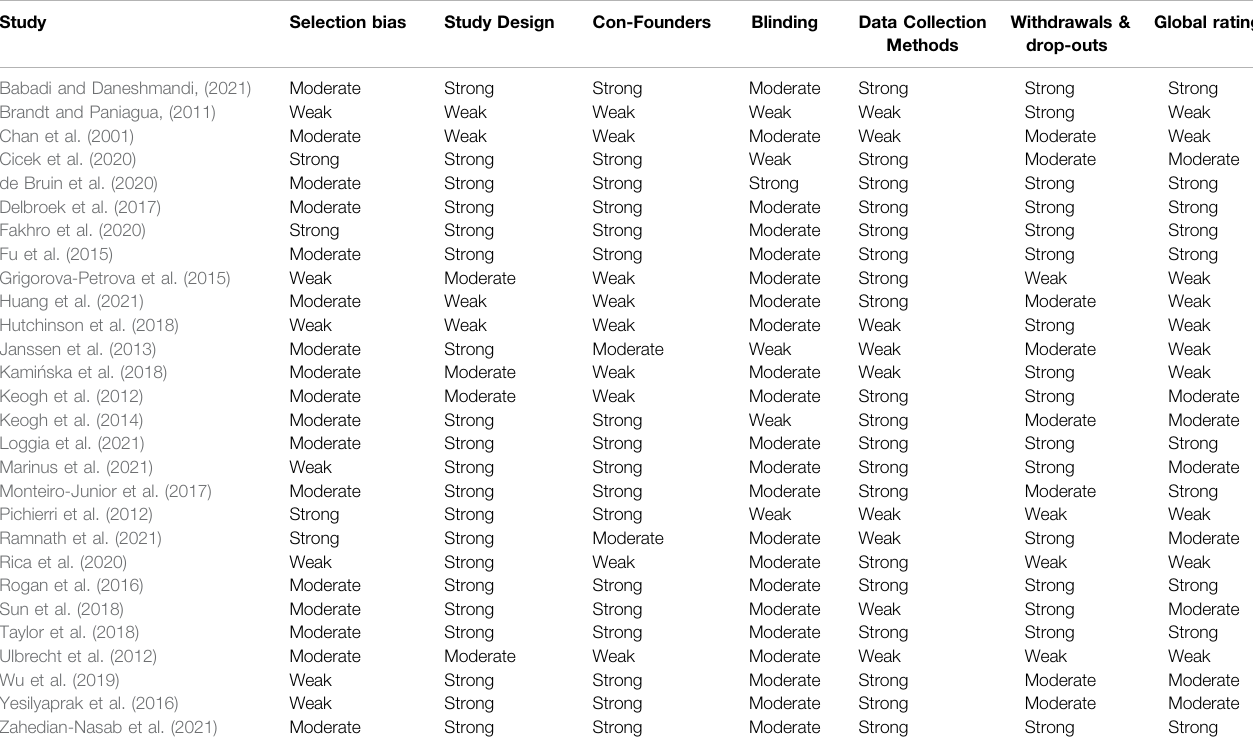
TABLE 1 | Results of methodological quality